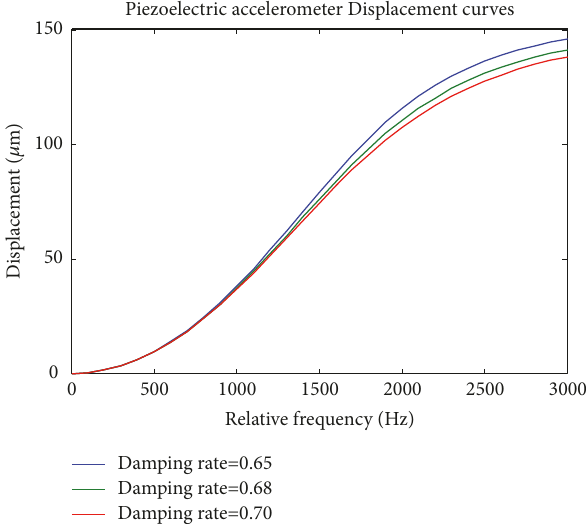
Figure 6: Displacement as a function of relative frequency for three values of damping rate in the case where the relative frequency is varied from 0 to 1500Hz.